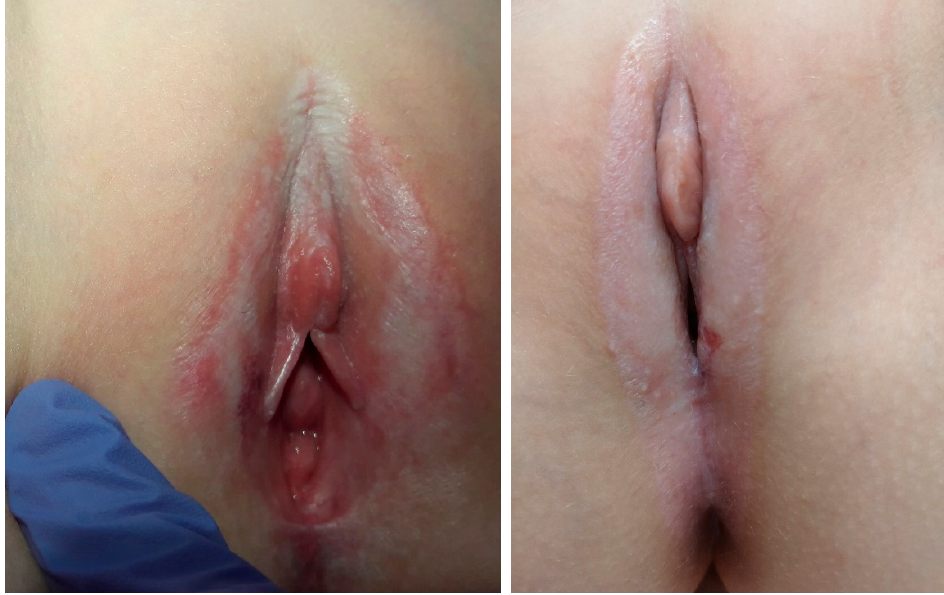
Figure 1. Classic vulvar lichen sclerosus in young girls (two cases)—own material.